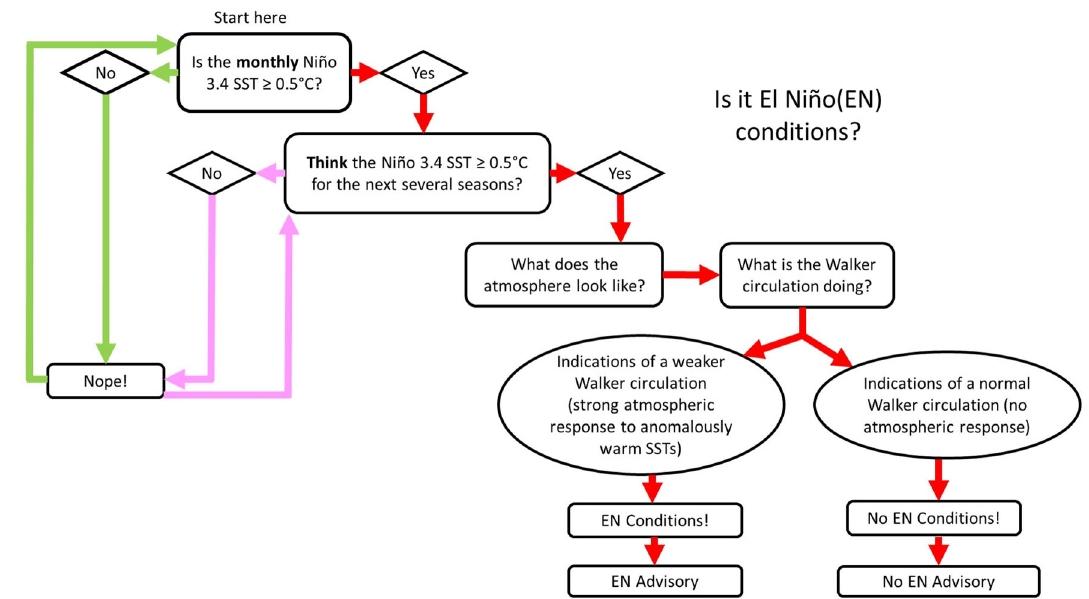
Fig. 5 Becker’s 2015 schematic from the ENSO Blog modified by the authors to provide more detail on decision making. Green and pink lines represent feedback loops, while red is the forecasting pathway in the decision